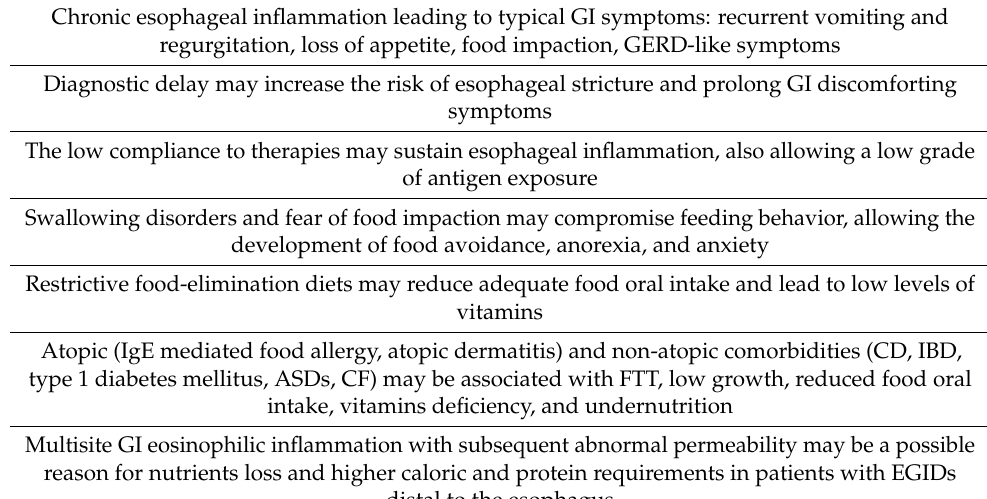
Table 4. Potential factors that may negatively influence the nutritional status of patients with